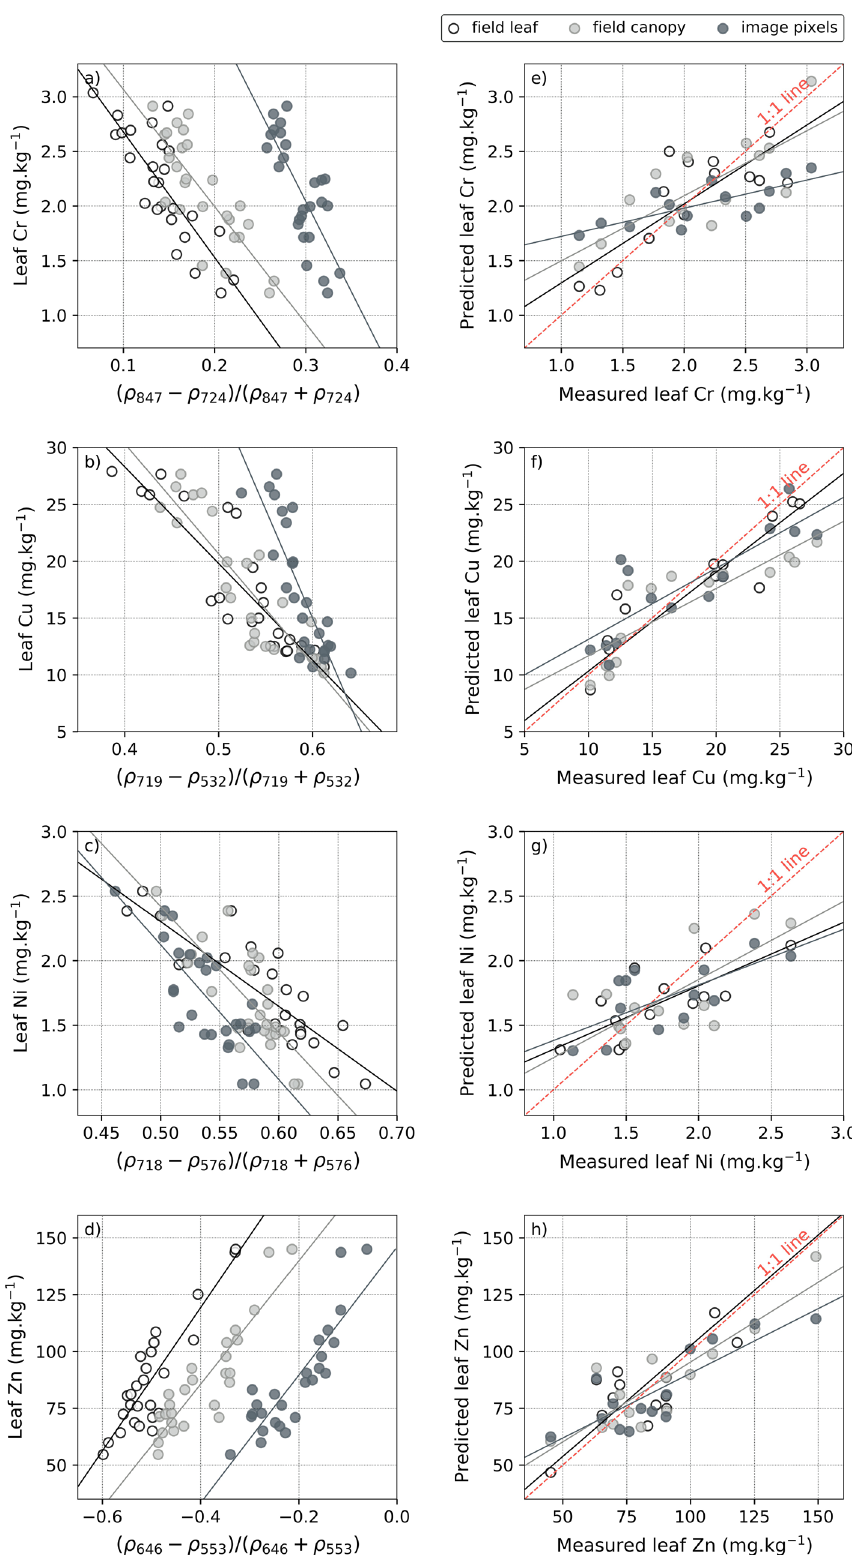
Figure 5. ( a – d ) Relationship between the optimized vegetation indices computed at leaf, canopy and image levels, and the four heavy metal contents analyzed in leaves ( n = 26 at each level). These data were used to calibrate coefficients of linear univariate regression equations, which were thereafter applied to the validation set for predicting heavy metal contents. ( e – h ) Comparison between the measured and predicted four heavy metal contents in leaves obtained with the optimized vegetation indices at leaf, canopy and image levels ( n = 14 at each level). See Table 2 the for the detailed regression equations, correlation coefficients ( r ) and prediction assessment metrics (RMSE,